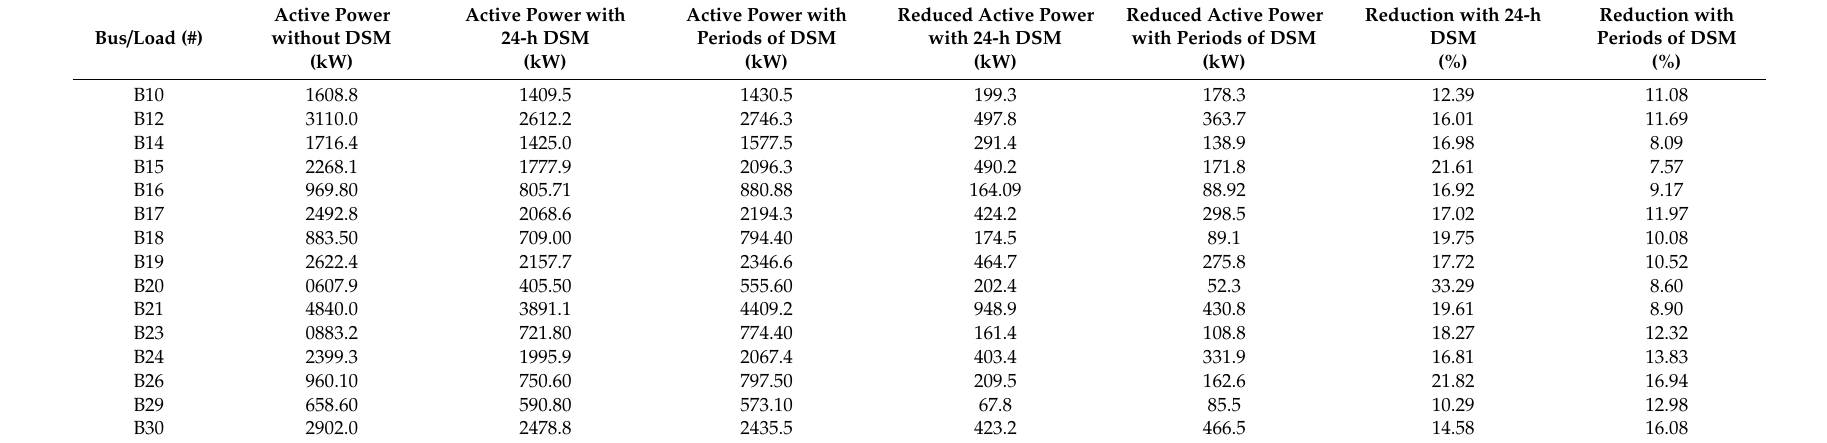
Table 8. Case VII: Active power with / without DSM.